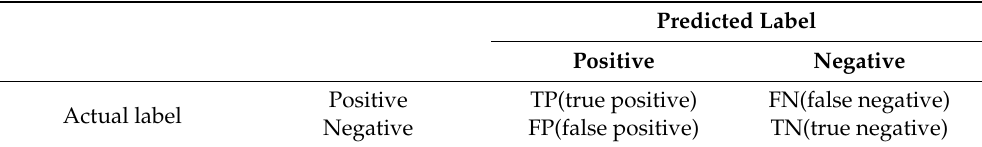
Table 1. The confusion matrix for the two-class classifier.